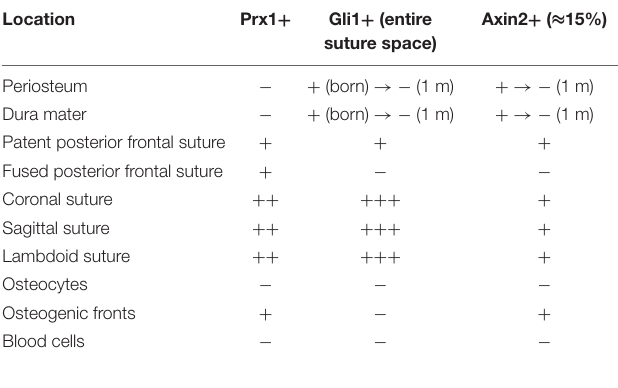
TABLE 2 | Distribution of identified populations of suture-derived stem